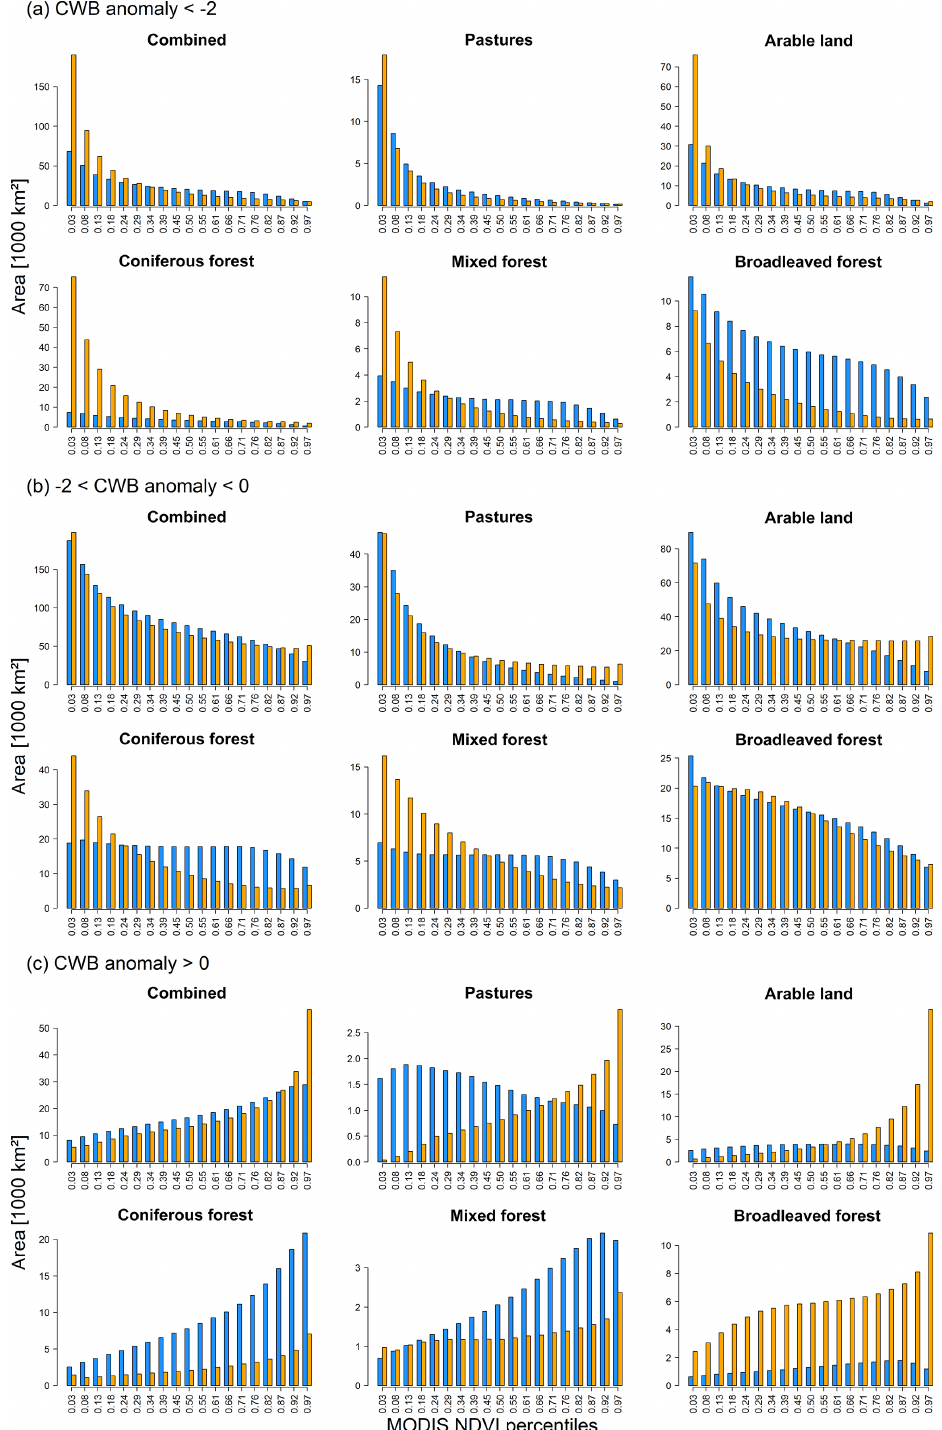
Figure 5. Histograms depicting the absolute areas (in units of thousands of square kilometres) representing the 19 NDVI quantiles pooled according to CORINE land cover classes for regions with (a) extreme water deficit (CWB-anomaly < − 2) vs. (b) weak water deficit ( − 2 < CWB-anomaly < 0) and (c) no water deficit (CWB-anomaly > 0). Blue bars refer to 2003 and orange bars to 2018. Histograms depicting the proportional areas are shown in Fig. S8 and results for MODIS EVI in Figs. S9 and